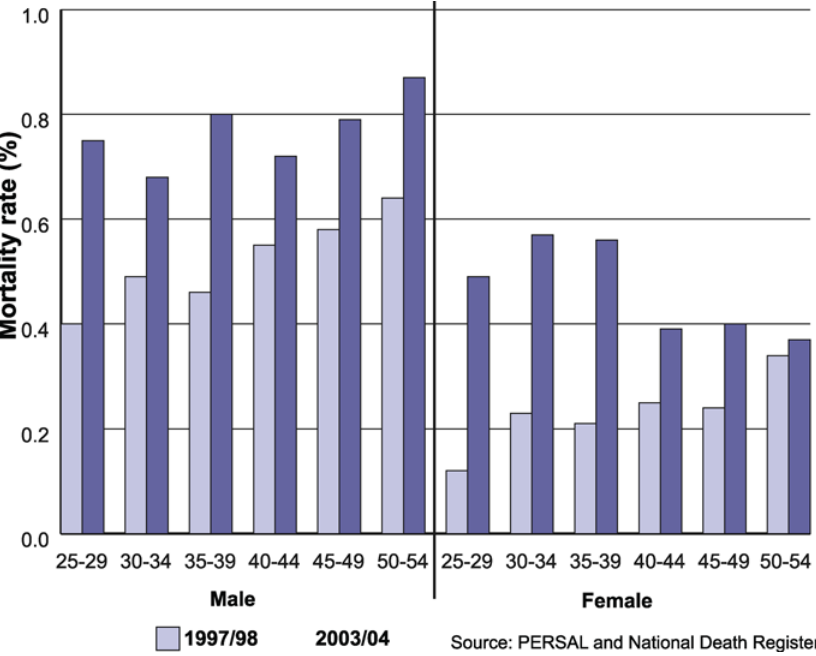
Figure 3. Educator Mortality Rates by Age and Gender, South Africa, 1997/1998 and 2003/2004 Figure derived from